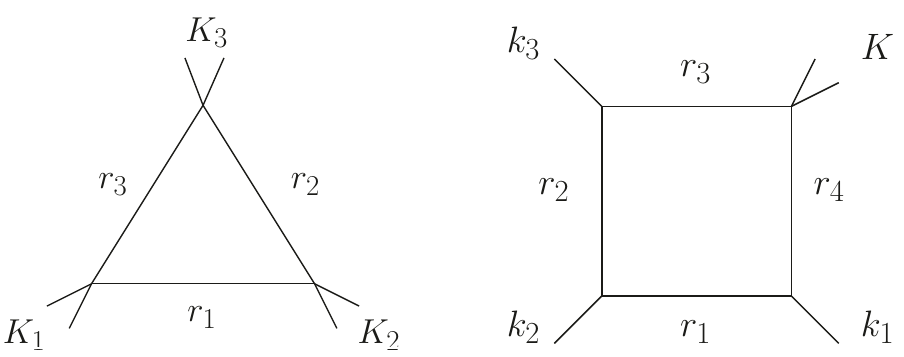
= 0, i = 1 ; 2 ; 3. Right: one-mass box i 6